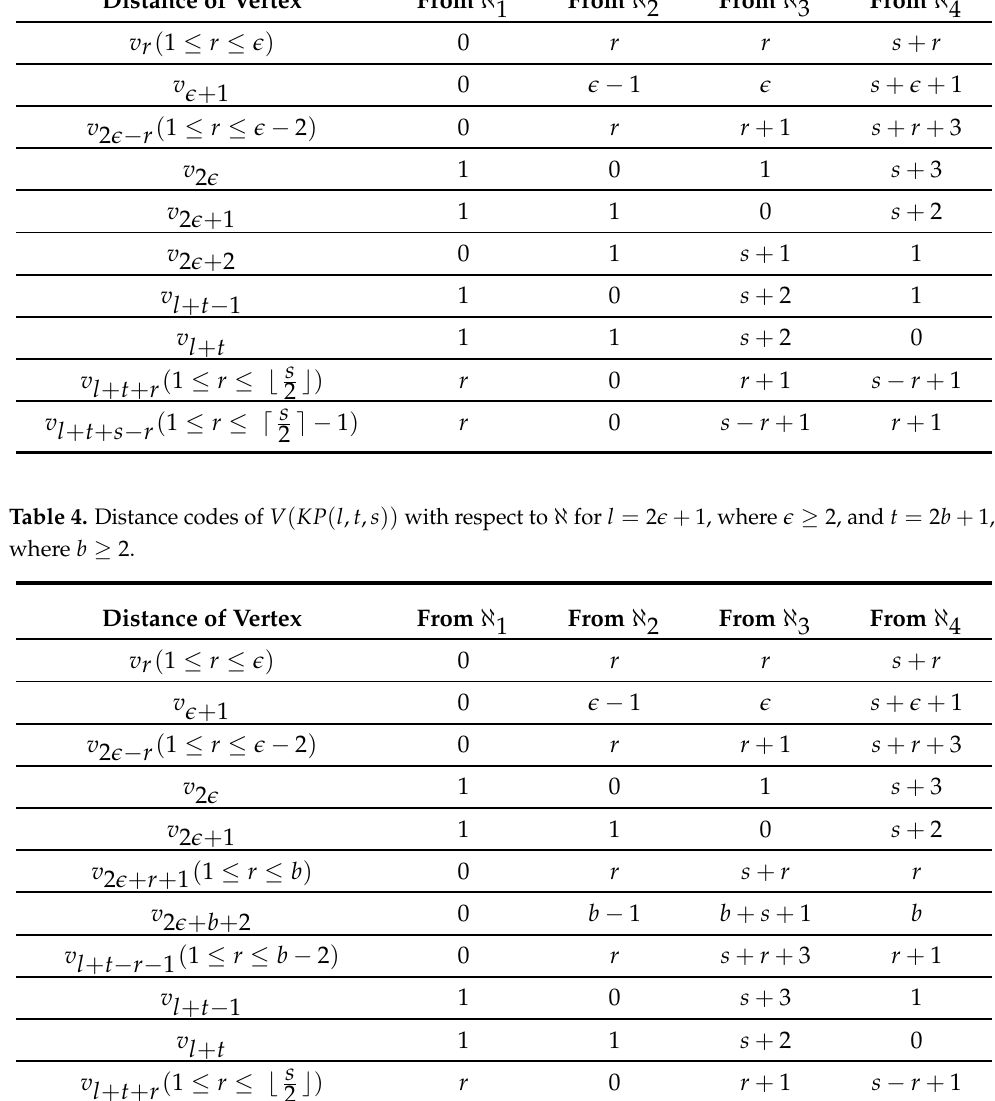
Table 3. Distance codes of V ( KP ( l , t , s )) with respect to ℵ for l = 2 (cid:101) + 1 when (cid:101) ≥ 2 and t = 3. Distance of Vertex From ℵ 1 From ℵ 2 From ℵ 3 From ℵ 4